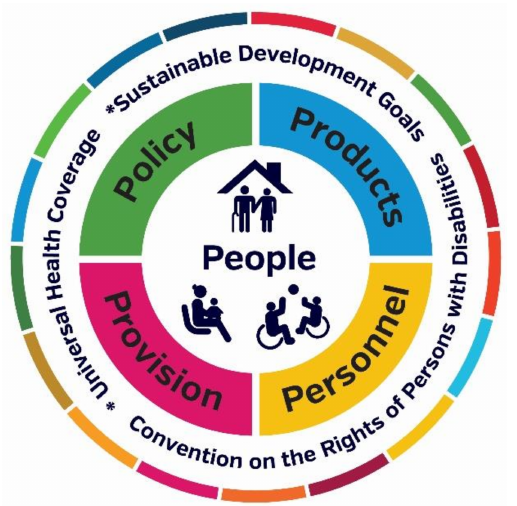
Figure 7. WHO’s 5P model for AT systems